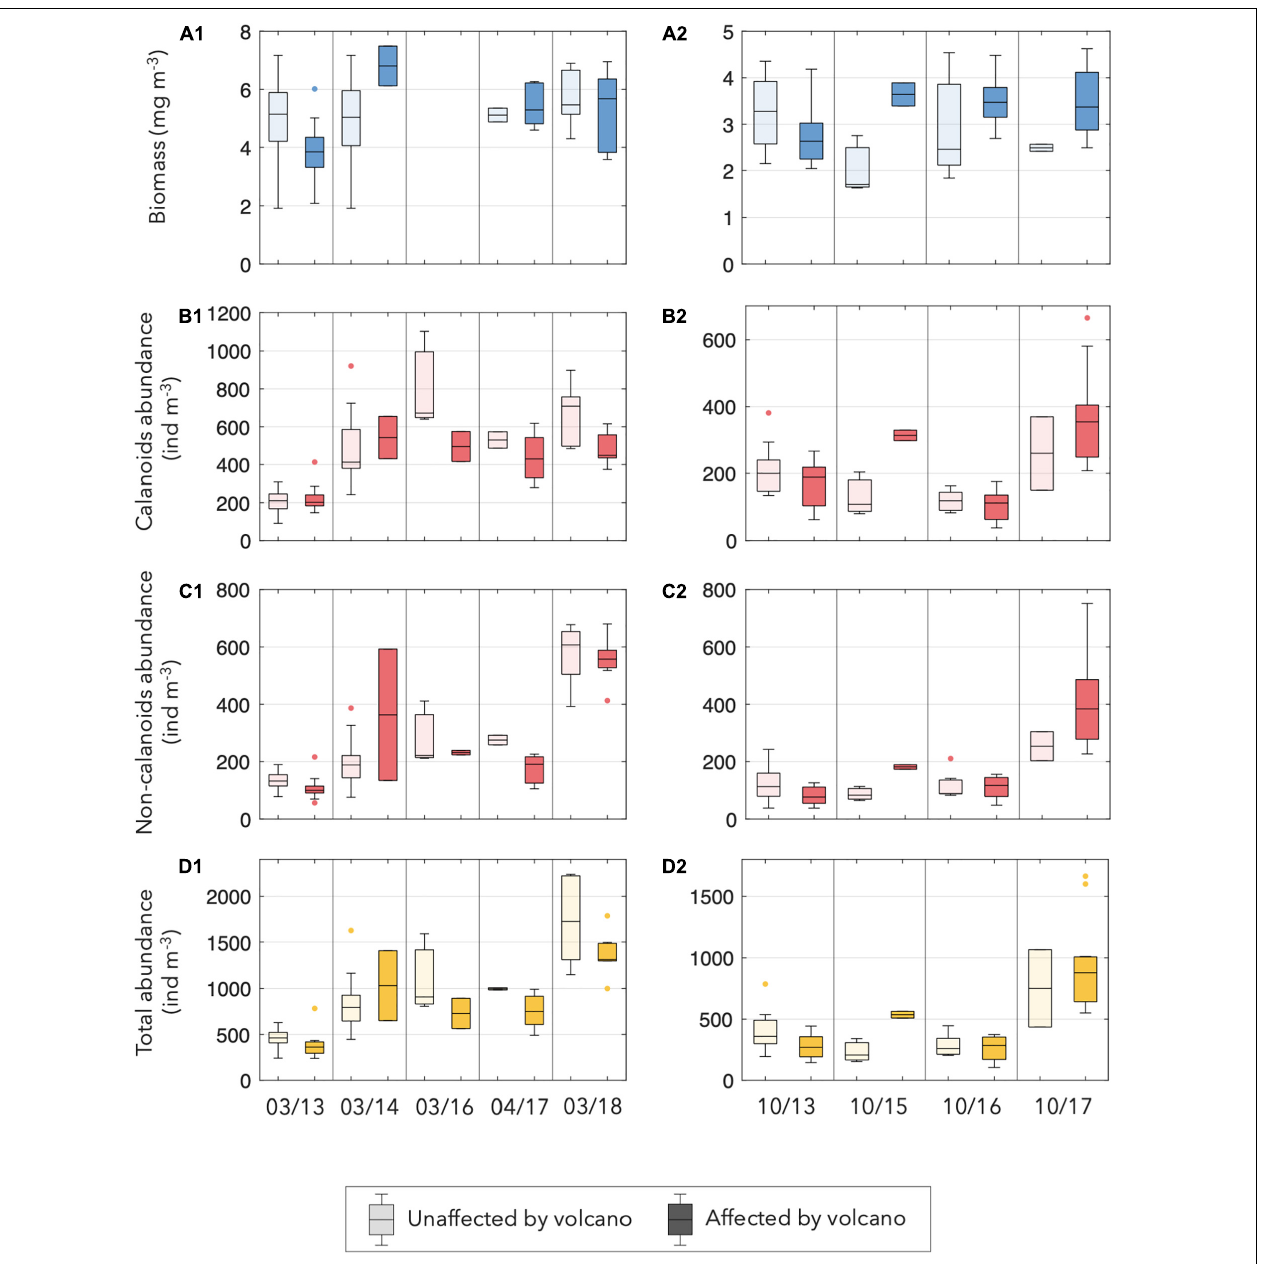
FIGURE 4 | Box plots of (A1,A2) biomass (mg m − 3 ), (B1,B2) copepod calanoids, (C1,C2) no calanoids, and (D1,D2) total zooplankton abundance (ind m − 3 ) at each cruise, separating the affected and the unaffected stations by the volcano influence and by season (panel 1 for spring and panel 2 for autumn). Note that no biomass data were available during March